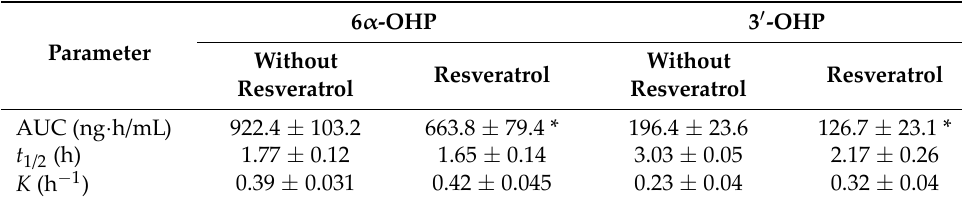
Table 5. Mean pharmacokinetic parameters of 6 α ‑OHP and 3 (5 mg/kg) to xenografted nude mice in the presence or absence of resveratrol.